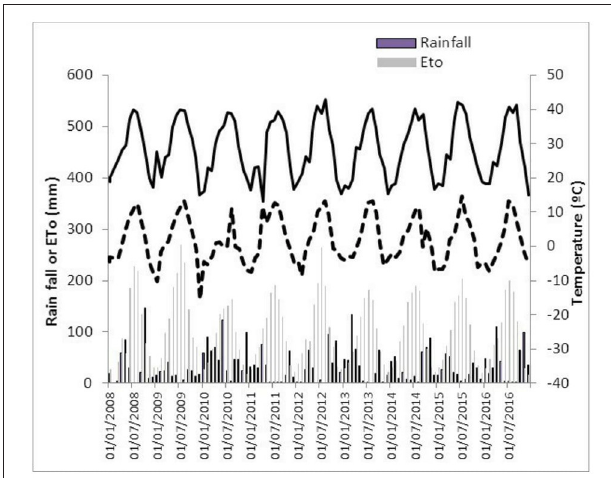
FIGURE 2 | Monthly rainfall, reference evapotranspiration, and minimum and maximum temperatures from January 2008 until December 2016 at the experimental orchard located in Puebla de Montalbán (Toledo, Spain).